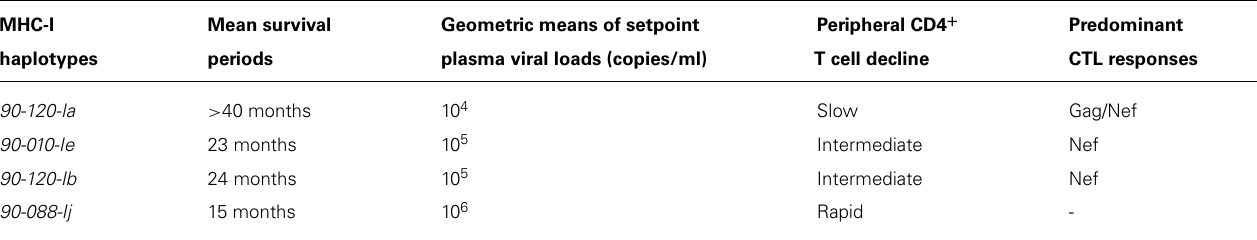
Table 1 |Association of MHC-I haplotypes with disease progression in SIV infection (Nomura etal., 2012).